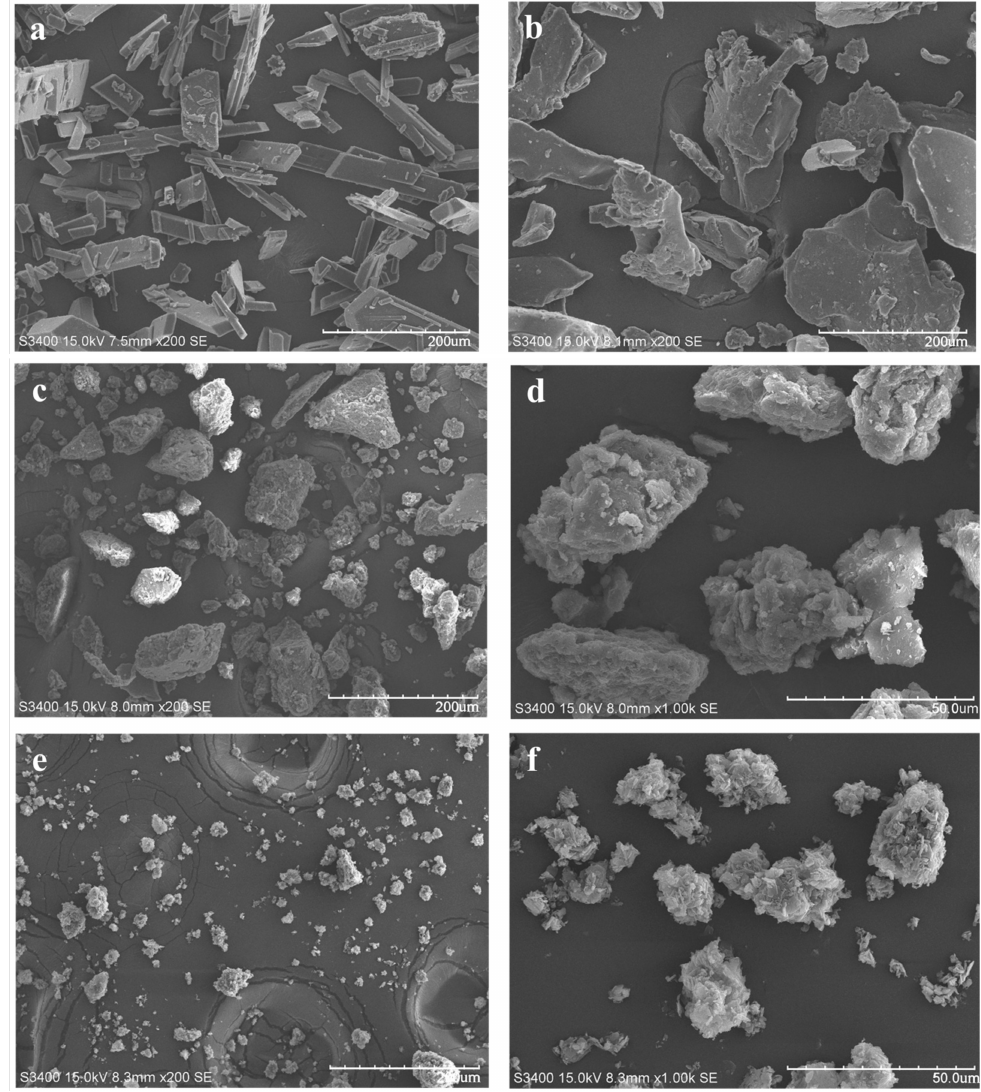
Figure 5. SEM images of ( a ) ERL, ( b ) ERL SDs, ( c , d ) ERL Control, ( e , f ) ERL MPs.